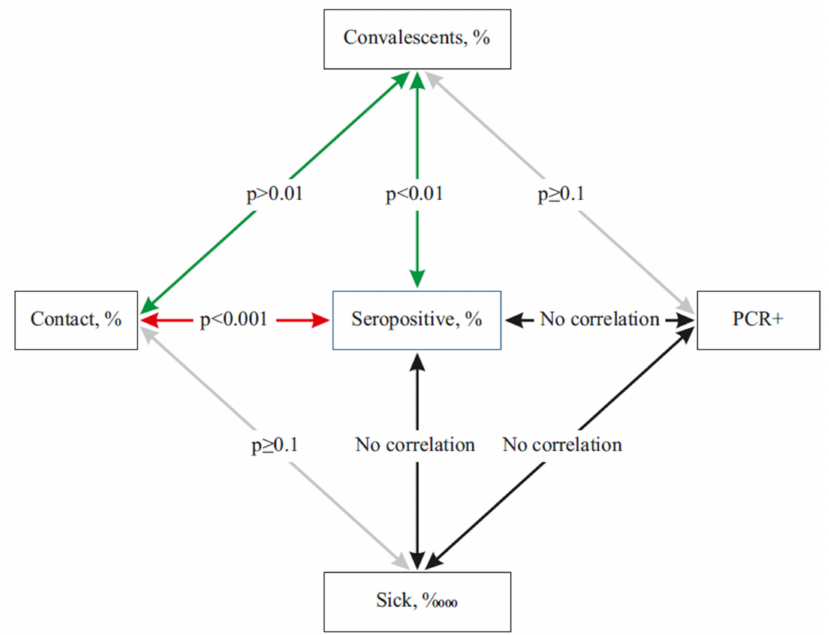
Figure 6. Spearman correlations between COVID-19 patient states. The diagram contains five main patient conditions, which describe basic features of the interaction between the coronavirus and a susceptible host. Key: seroprevalence—the proportion of seropositive individuals in the population according to ELISA data; patients—infected with SARS-CoV-2 based on PCR results and, as a rule, having clinical manifestations of COVID-19; convalescents—patients who have recovered from COVID-19, based on PCR results; contact—persons who have had verified contact with a COVID-19 patient; PCR + —persons with a positive PCR test result without any other clinical manifestations. Colored lines mark reliable correlations between the indicators. Weak correlations are marked with gray lines; black lines indicate an absence of correlation. Reliability of relationship values ( p ) are shown on the